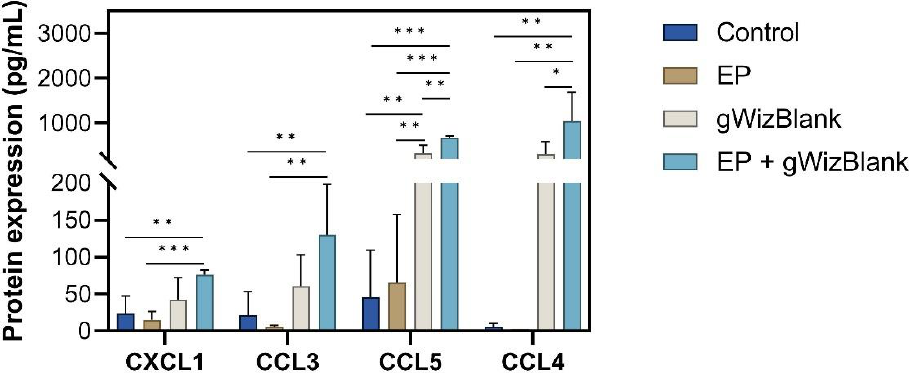
Figure 5. Detection of chemokine proteins in the medium of B16-F10 cells. EP, electrotransfer. n = 4 – 5 per group. *** p < 0.001; ** p < 0.01; * p <